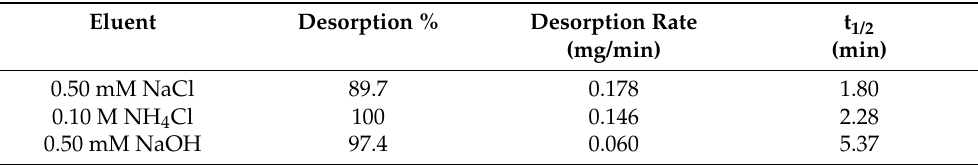
Table 6. Desorption of Cr(VI) ions from AEAPTES-silica beads with the amount of amino groups of 0.220 mmol/g in three different eluents at 30 ◦